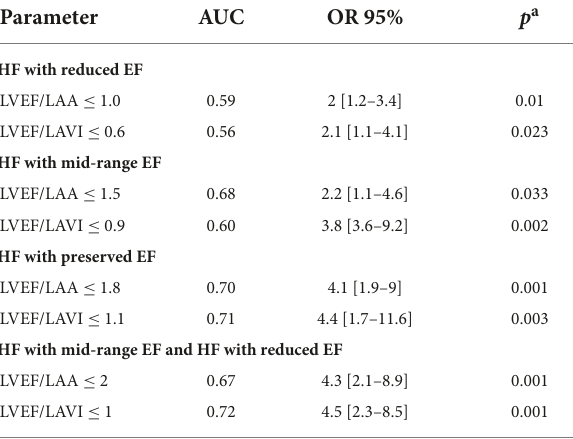
TABLE 4 Univariate regression analysis and ROC study results of novel echocardiographic parameters in subpopulation of patients with HF. Parameter AUC OR 95% p a HF with reduced EF